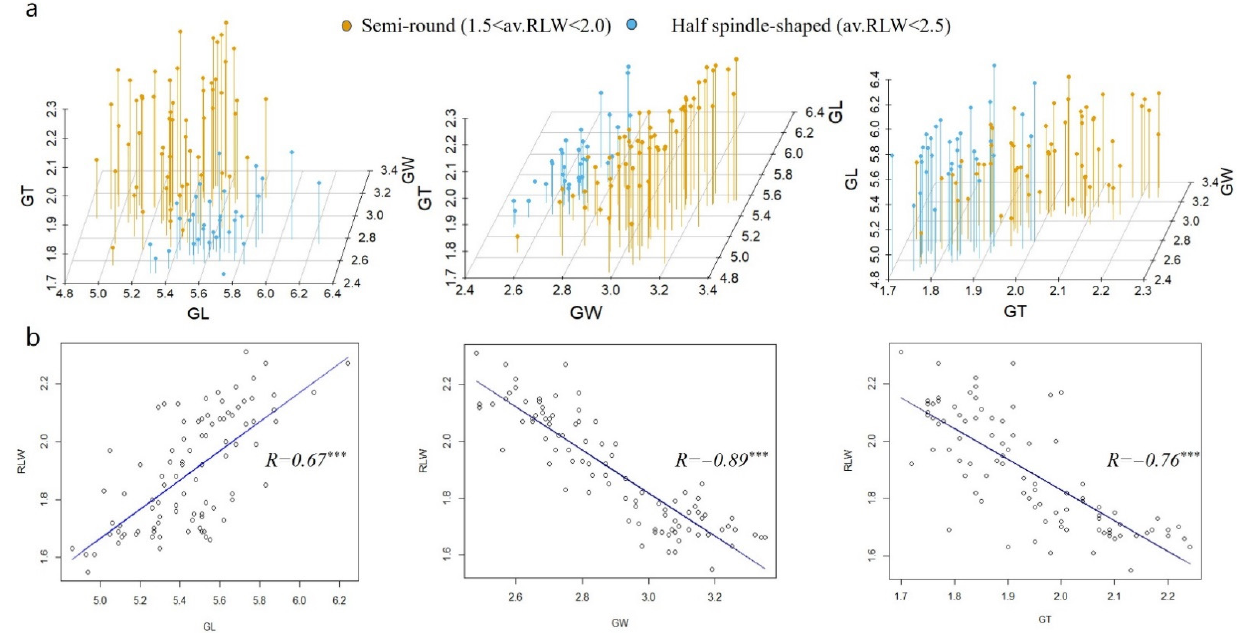
Figure 2. The 3D scatter plots with vertical lines for grain shape, based on the following three traits: grain length (GL), grain width (GW), and grain thickness (GT) ( a ). Scatter plots with a correlation line for the ratio of length to width (RLW) predicted based on the GL, GW, and GT of the population. r refers to the correlation coefficient analyzed at p < 0.001 ( b ). Significance levels: *** p < 0.001.